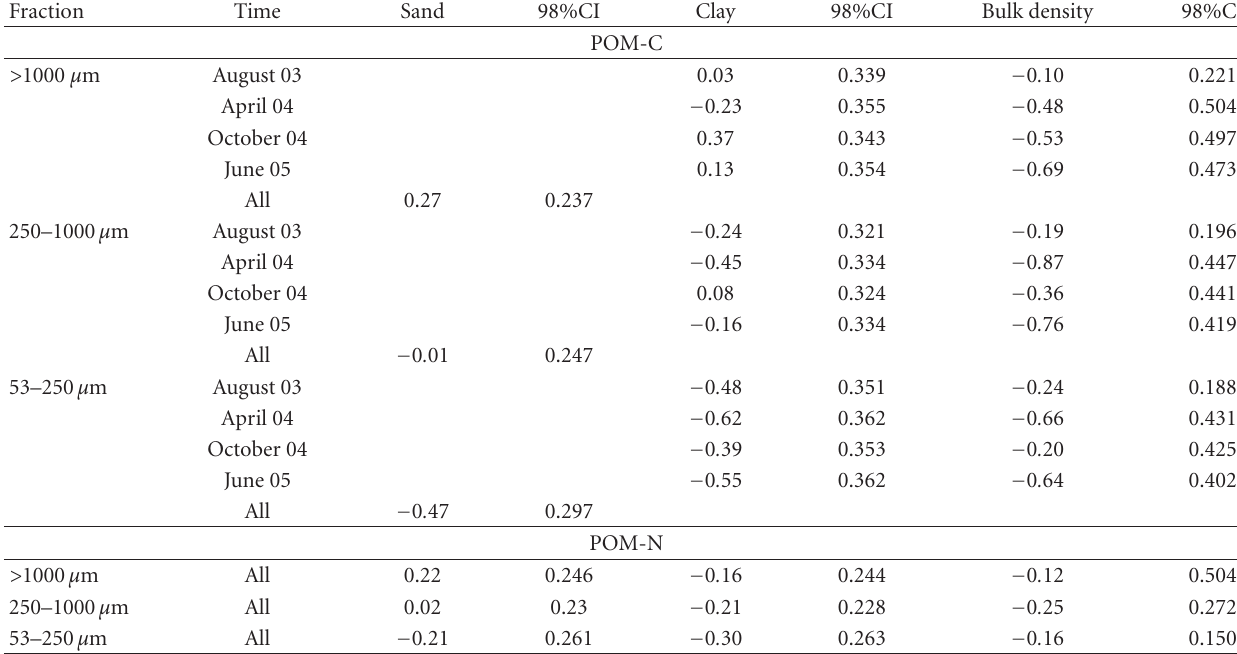
Table 7: Standardized partial regression coe ffi cients relating soil physical properties to particulate organic matter (POM)-C and -N fractions. Numbers in the columns labeled 98%CI are the half-width of the confidence